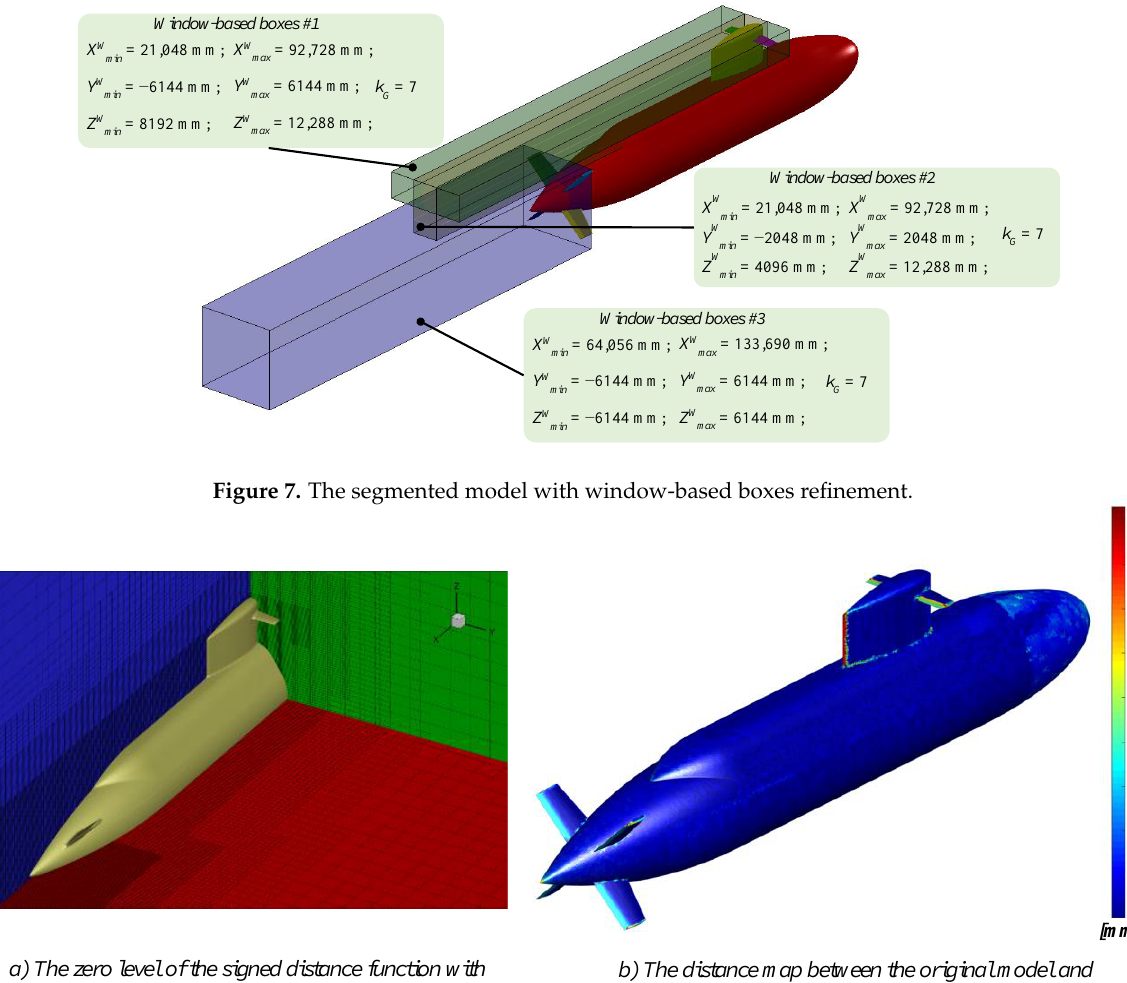
Figure 8. The grid generation